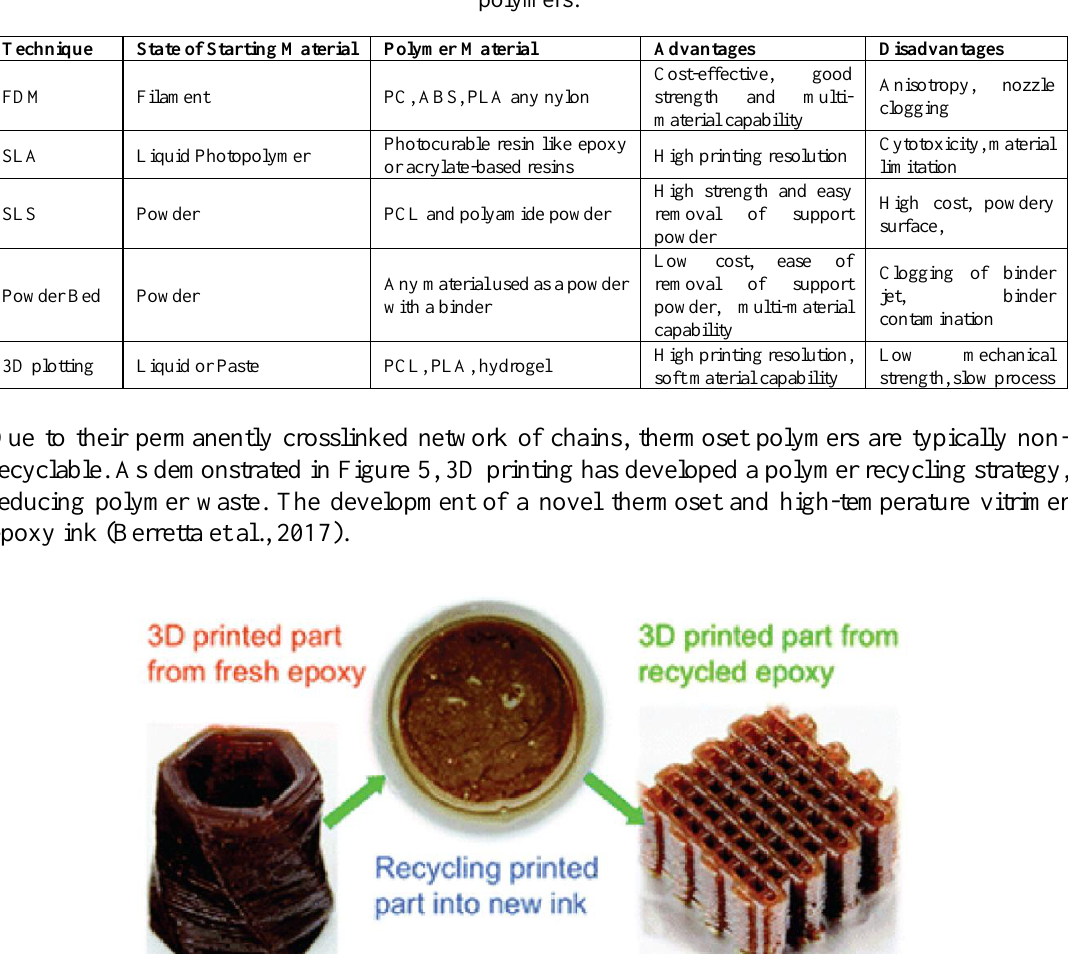
Table 3. Different techniques of AM along with the input material, advantages, and disadvantages for polymers.